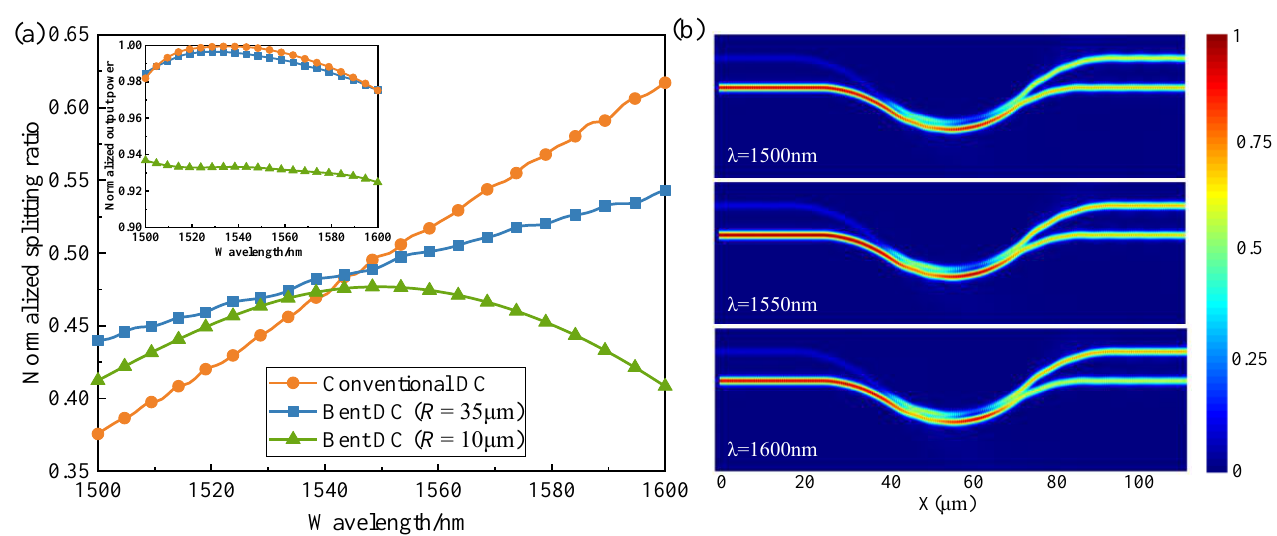
Figure 3. ( a ) Wavelength dependence of transmittance of the different DC at cross port; inset: the total output power of the different DCs; ( b ) 3D FDTD simulated power distribution of bent DC with R = 35 μm and θ = 25°.